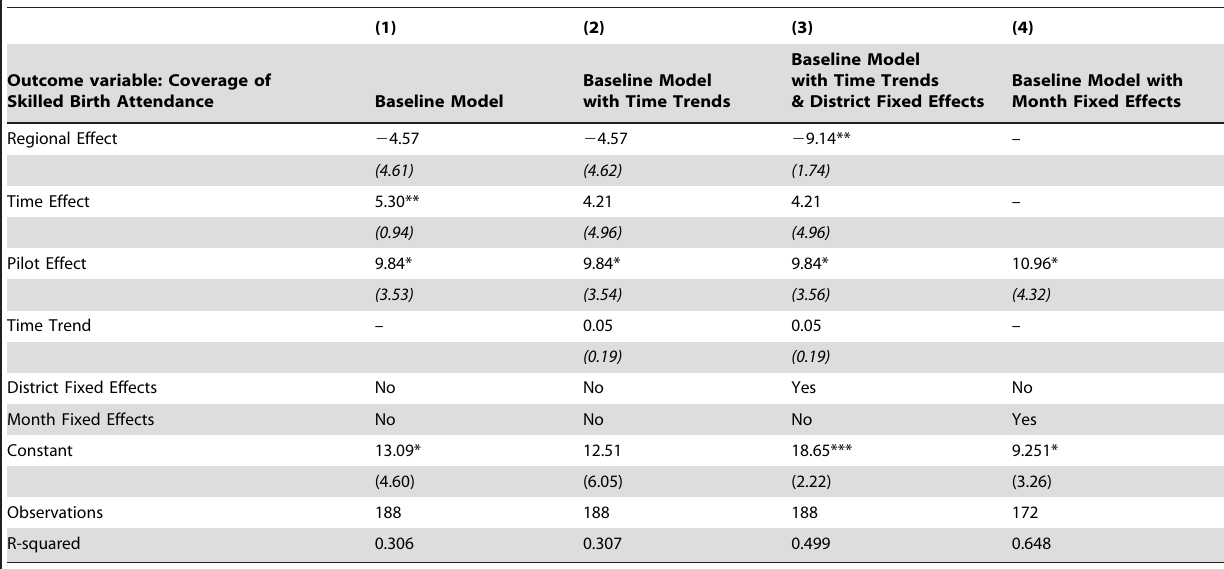
Table 4. Statistical Results.